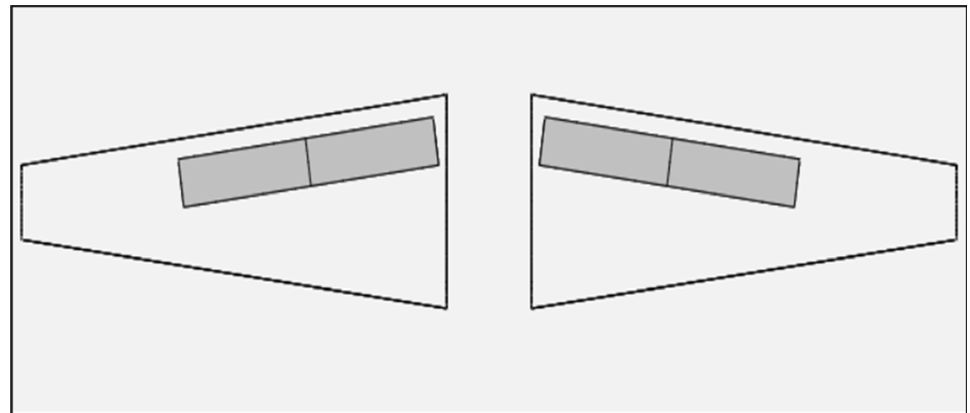
Figure 16. Schematic of battery location in the wing (in OpenVSP).